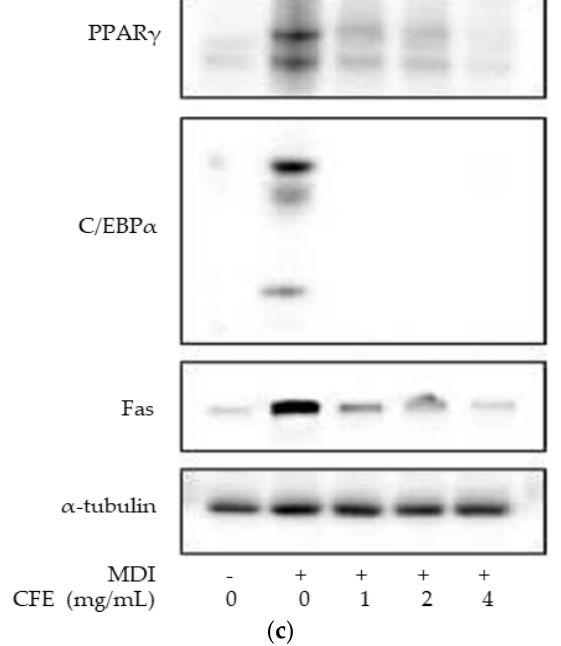
Figure 3 . CFE inhibits lipid accumulation in 3T3-L1 cells. ( a ) Confirmation of cell viability on adipocyte differentiation using the MTT assay. ( b ) Confirmation of the inhibitory effect on adipocyte differentiation using oil red O staining. ( c ) Confirmation of CFE-induced changes in the expression of protein related to adipocyte differentiation using Western blot analysis. Data are representative of more than three separated experiments and are presented as mean ± SD. Significant differences are noted as * p < 0.05, ** p < 0.01 as compared to differentiated 3T3-L1 cells without CFE treatment. MDI: methylisobutylxanthine, dexamethasone, and insulin, NAC: N-Acetyl-cysteine, ## p < 0.05 as compared to normal cells.